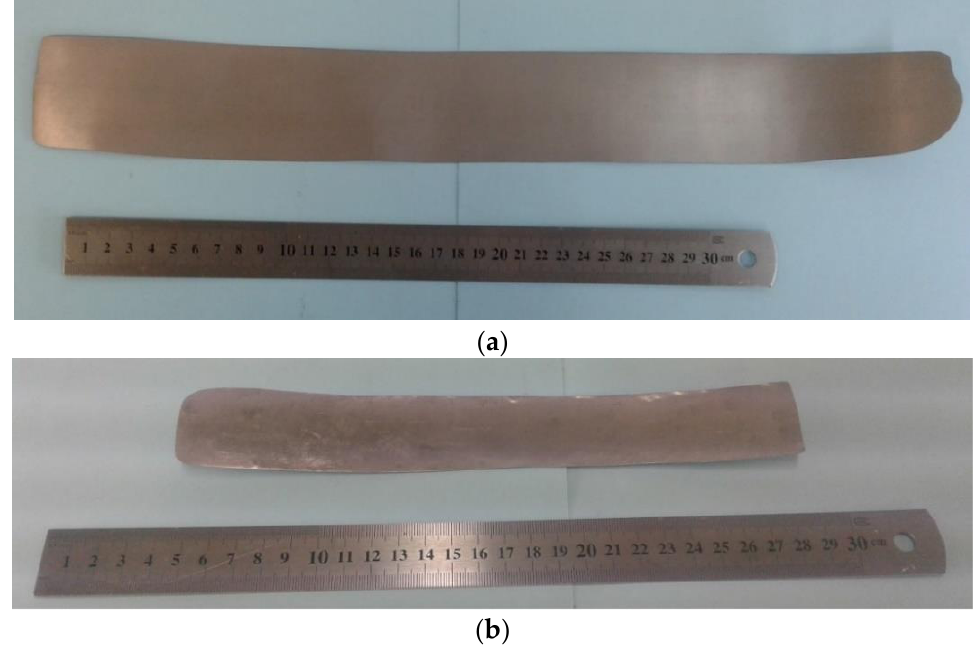
Figure 6. Typical titanium strips produced in this study: ( a ) a green titanium strip; ( b ) a sintered titanium